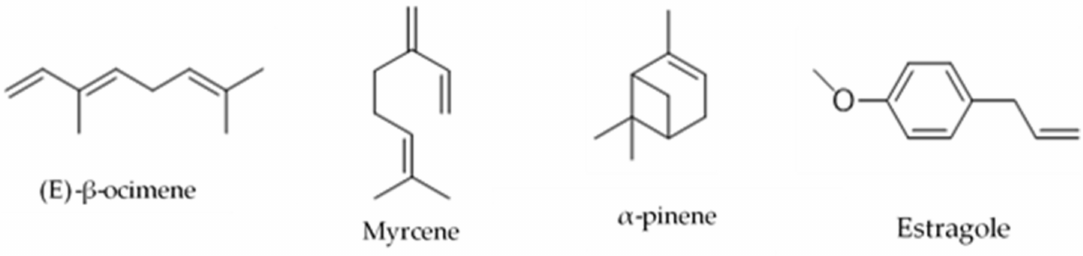
Figure 2. Isolated compounds from P. ruderale and P. gracile with insecticidal